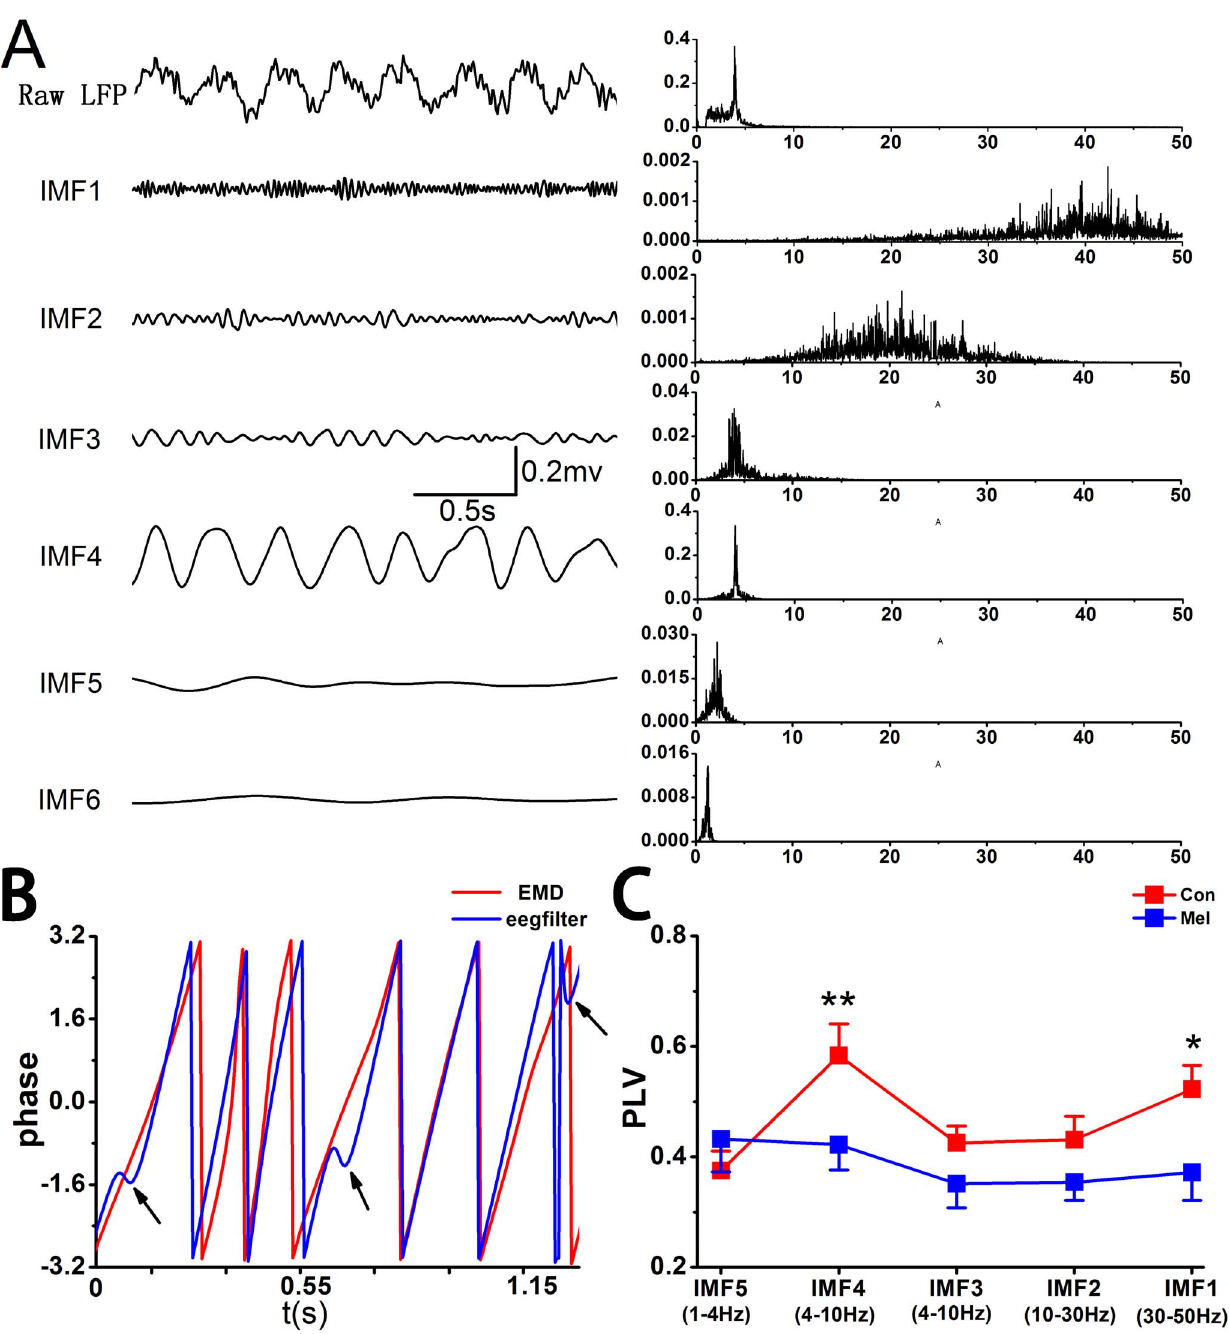
Figure 2. EMD-based PLV analysis between CA3 and CA1 in both Con group and Mel group. A. Examples of LFP-EMD in CA1 obtained from a normal rat. The first column illustrates the raw signals and IMFs and the second column shows the corresponding power spectra. B. The example of instantaneous phases of IMF4 (red) and band-filtered within 4 to 8 Hz (blue) signal. C. The EMD-based PLVs between CA3 and CA1 are significantly decreased in IMF4 and IMF1 in Mel group. Data represent mean 6 SEM. *p , 0.05 and **p , 0.01 comparison between Mel group and Con group. doi:10.1371/journal.pone.0077796.g002 apparently reduced in CA3 region, and almost disappeared from 7.591 6 1.148, U= 3, p= 0.016). By comparing the normal animals and the melamine-treated ones, it was found that there were CA3 to CA1 as well as in CA1 region in Mel group (Fig. 4B). There were significant differences of MI data between Con and significantly positive correlations of MI values either between Mel groups, respectively (Fig. 4C), in CA3 region (4.324 6 0.785 vs. intra-CA3 and inter-CA3-CA1 (Fig. 4D, n = 12, r= 0.729, 7.155 6 1.379, U= 4, p= 0.025), CA3-CA1 (3.281 6 0.808 vs. p = 0.007) or between inter-CA3-CA1 and intra-CA1 (Fig. 4E, n =12, r=0.941, p , 0.0001). 7.597 6 1.368, U= 4, p= 0.025) and CA1 area (3.846 6 0.523 vs.